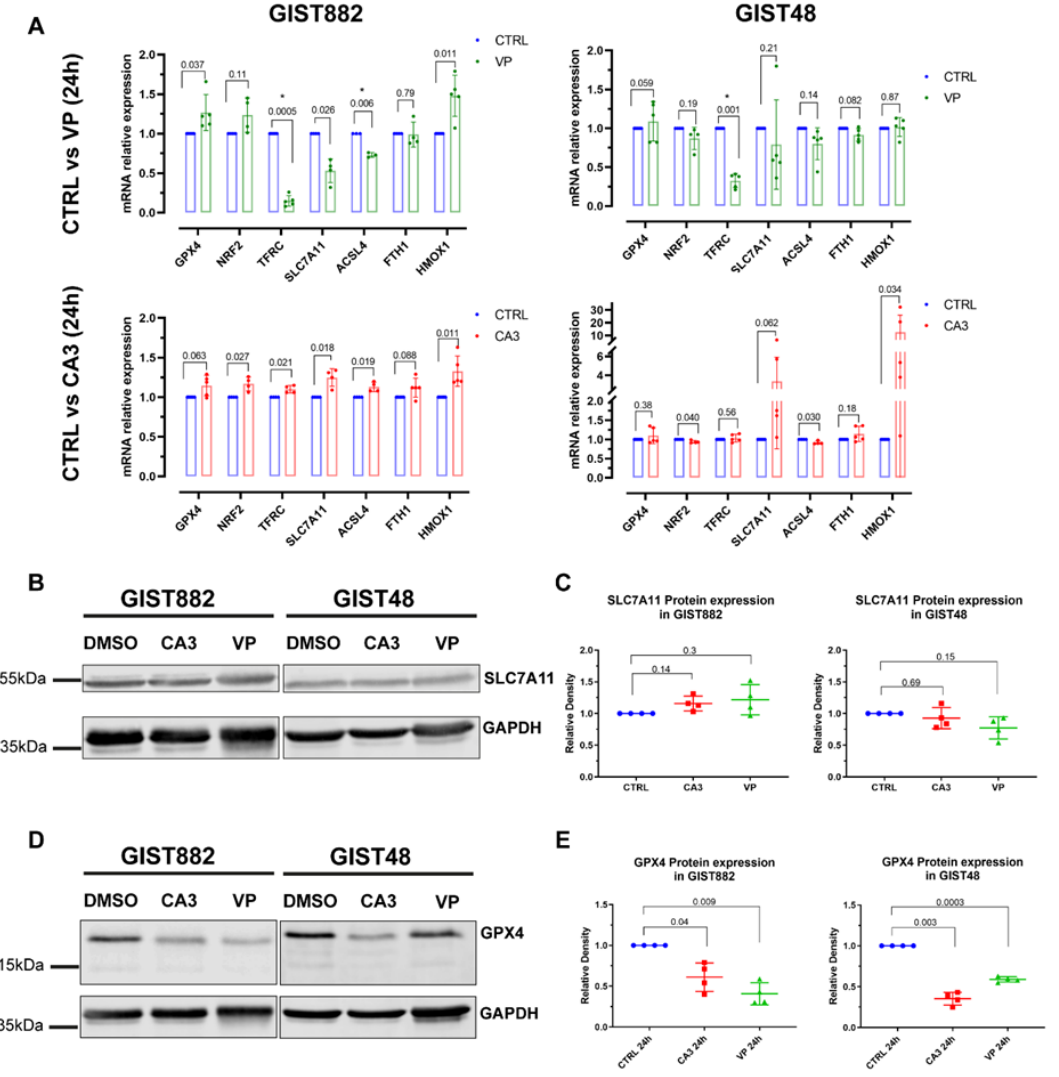
Figure 7. VP and CA3 do not modify the mRNA expression of a series of key ferroptosis genes but significantly deplete GPX4 protein expression in GIST882 and GIST48 cells. GIST882 and GIST48 cells were treated with VP (2 μM or 0.5 μM for GIST882 and GIST48, respectively) or CA3 (670 nM for GIST882 and GIST48) for 24 h. ( A ) The relative mRNA expression of indicated ferroptosis genes was analyzed by qPCR and presented as fold changes (treatment relative to control cells). p -values were calculated using the multiple-ratio paired t-test. p -values < 0.01 were considered statistically significant. Data presented as mean values ±SD are shown from four or five independent experiments with technical triplicates for each experiment. ( B ) SLC7A11 protein expression was determined by Western blot in GIST882 and GIST48 after CA3 and VP treatment and GAPDH was used as a loading control. ( C ) The quantification of SLC7A11 protein expression normalized to GAPDH and untreated cells (left panel: GIST882; right panel: GIST48). ( D ) GPX4 protein expression was determined by Western blot in GIST882 and GIST48 after CA3 and VP treatment and GAPDH was used as a loading control. ( E ) The quantification of GPX4 protein expression normalized to GAPDH and untreated cells (left panel: GIST882; right panel: GIST48). Thirty microgram protein added to each lane. Data presented as mean values ±SD. p -values were calculated with the Pearson normality test followed by repeated-measures one-way ANOVA with Geisser–Greenhouse correction and Tukey’s multiple comparisons test. p -values < 0.05 were considered statistically significant. All the whole western blot figures can be found in the supplementary materials.